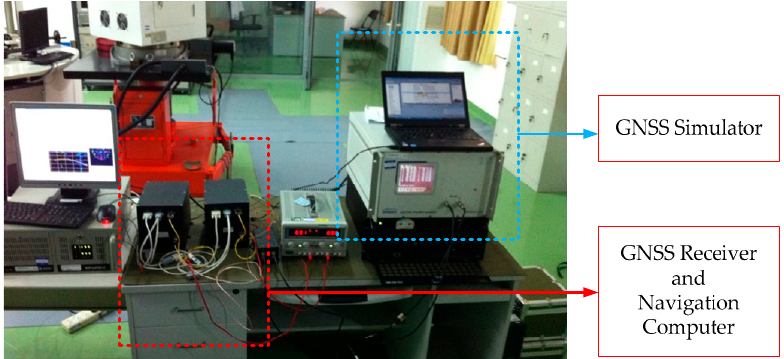
Figure 4. Devices employed in the semi-physical simulation experiments. Table 1. Sensor error settings employed in the simulation experiments.